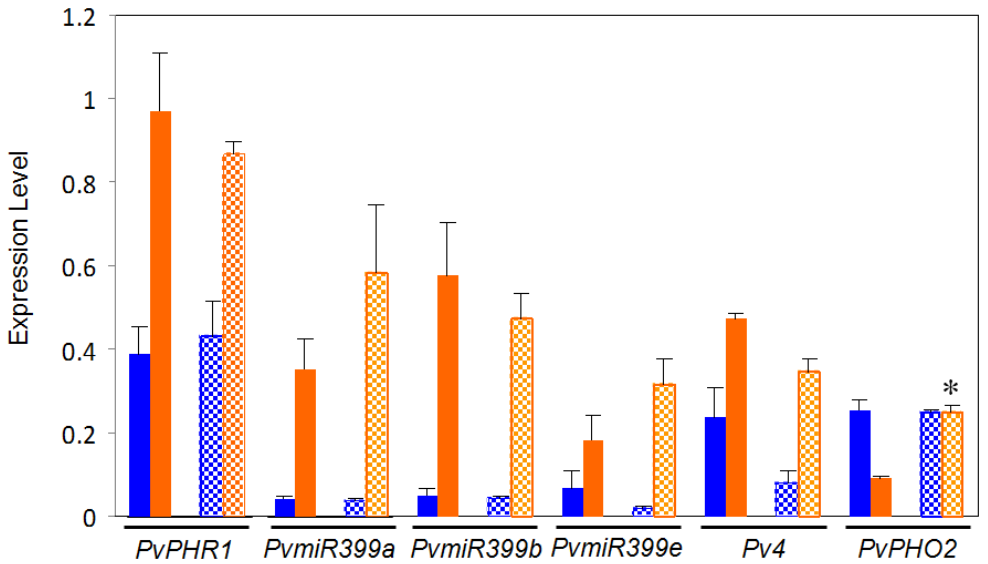
Figure 2. Expression of regulatory genes from the PvPHR1 signal pathway in roots of common bean BAT477 (solid bars) and DOR364 (hatched bars) genotypes. Plants were grown for three weeks under P sufficient (blue bars) or in P deficient (orange bars) conditions. Transcript levels were determined by qRT-PCR. Values are the mean (±SE) from three independent experiments with nine replicates per experiment. * Significantly different response to P deficiency between BAT477 and DOR364 ( p ≤